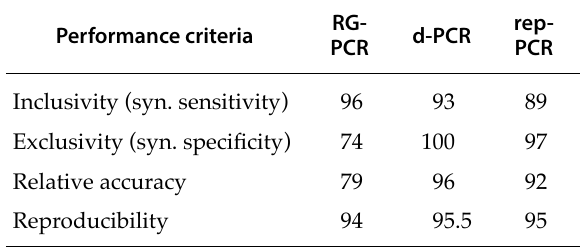
Table 4 . Performance criteria for detection of Pseudomonas syringe pv. actinidiae obtained by specific PCR (RG-PCR: Rees-George et al ., 2010; d-PCR: Gallelli et al ., 2011) and rep-PCR (Louws et al ., 1994) on bacterial cultures reported in Table 1. All values were expressed in percentage